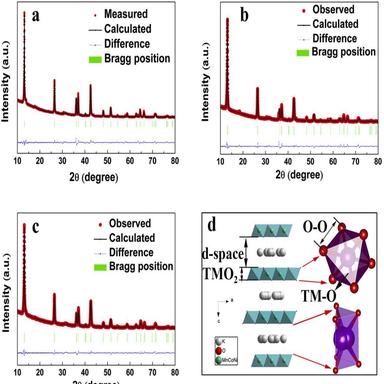
Structure characterization of as-prepared samples. XRD profiles and Rietveld refinement plot of the (a) pristine, (b) Mg-doped and (c) Al-doped samples. (d) Schematic illustration of layered structure viewed along the b axis of the P3-type crystal structure and the representation of TMO6 octahedra, KO6 triangular prism.